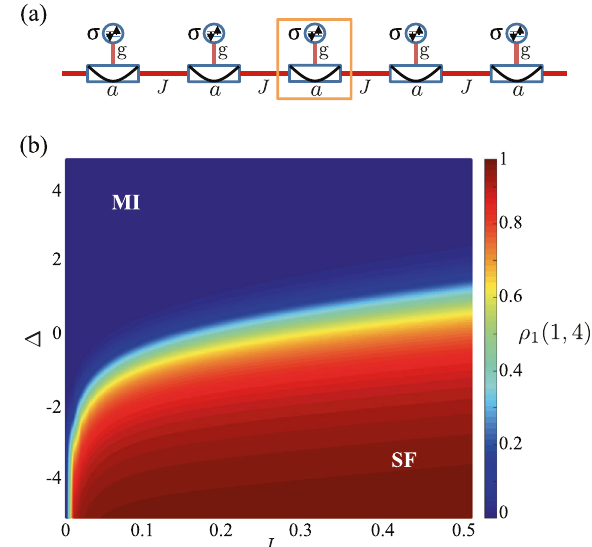
Fig. 1 Quantum phase transition in JC lattice. a Schematic of a 1D JC lattice. Circles (rectangles) represent qubits (cavity modes) with light – matter coupling g and hopping rate J . b Single-particle density matrix ρ 1 (1, 4) vs hopping rate J and detuning Δ for a fi nite-sized lattice at unit fi lling with N = L = 6. Here we let g be the energy unit with g ≡